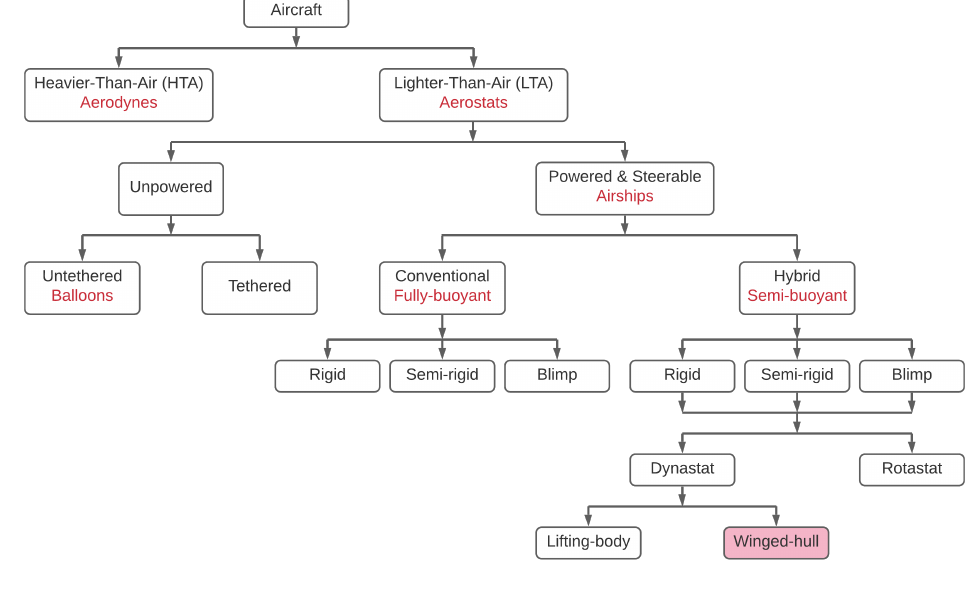
Figure 1. Classification of